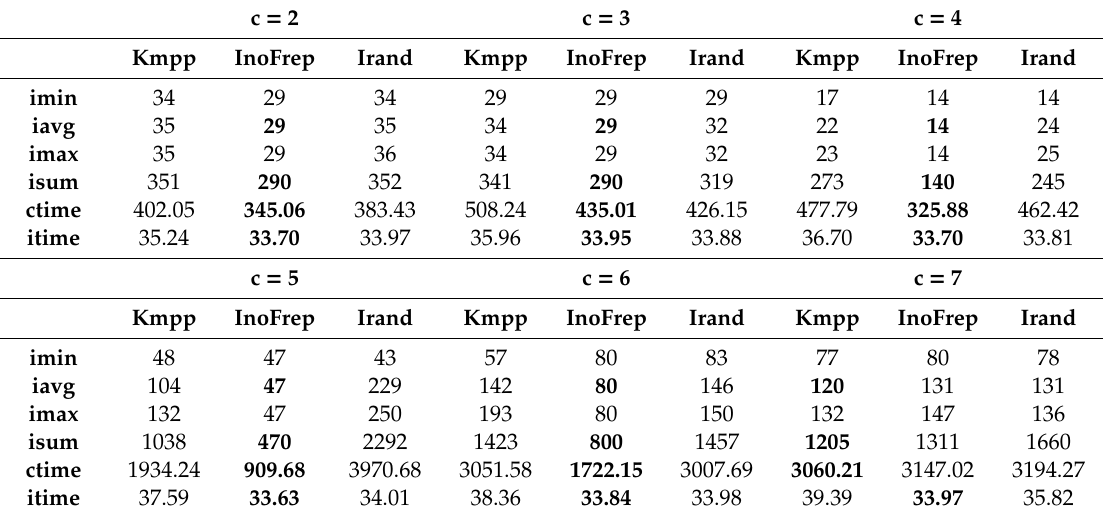
Table 3. Iteration counts and execution time required by the compared initialization algorithms. c = 2 c =